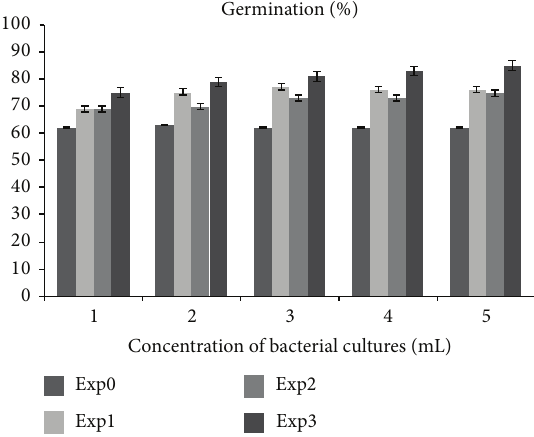
Figure 3: Germination percentage of Vigna unguiculata seeds sown in vermiculitesupplemented with Bacillus cereus ,with Pseudomonas spp., and with their consortium at five different concentrations (1, 2, 3, 4, and 5 mL) and in the control. Exp0: nutrient solution (control), Exp1: Bacillus cereus , Exp2: Pseudomonas spp., Exp3: consortium of Bacillus cereus + Pseudomonas spp.